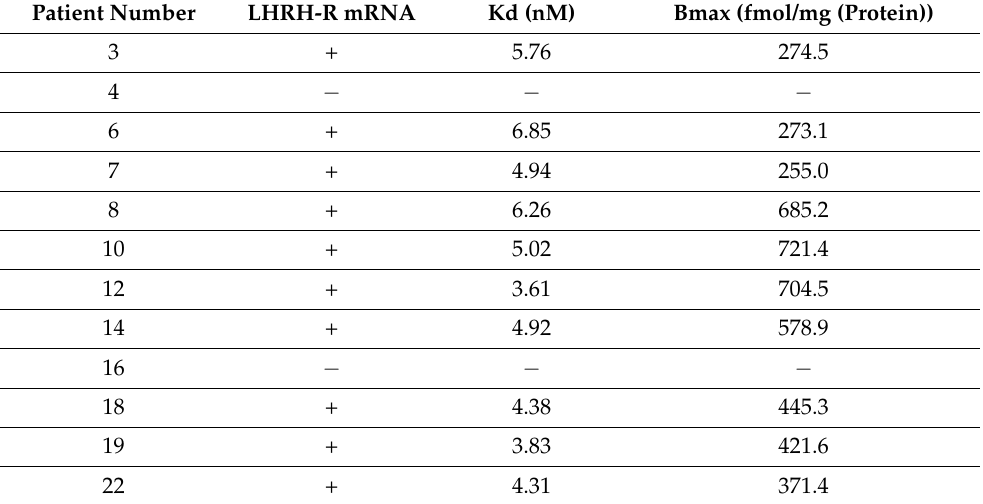
Table 3. Expression of mRNA and binding characteristics of LHRH-R in 12 human bladder cancer specimens.